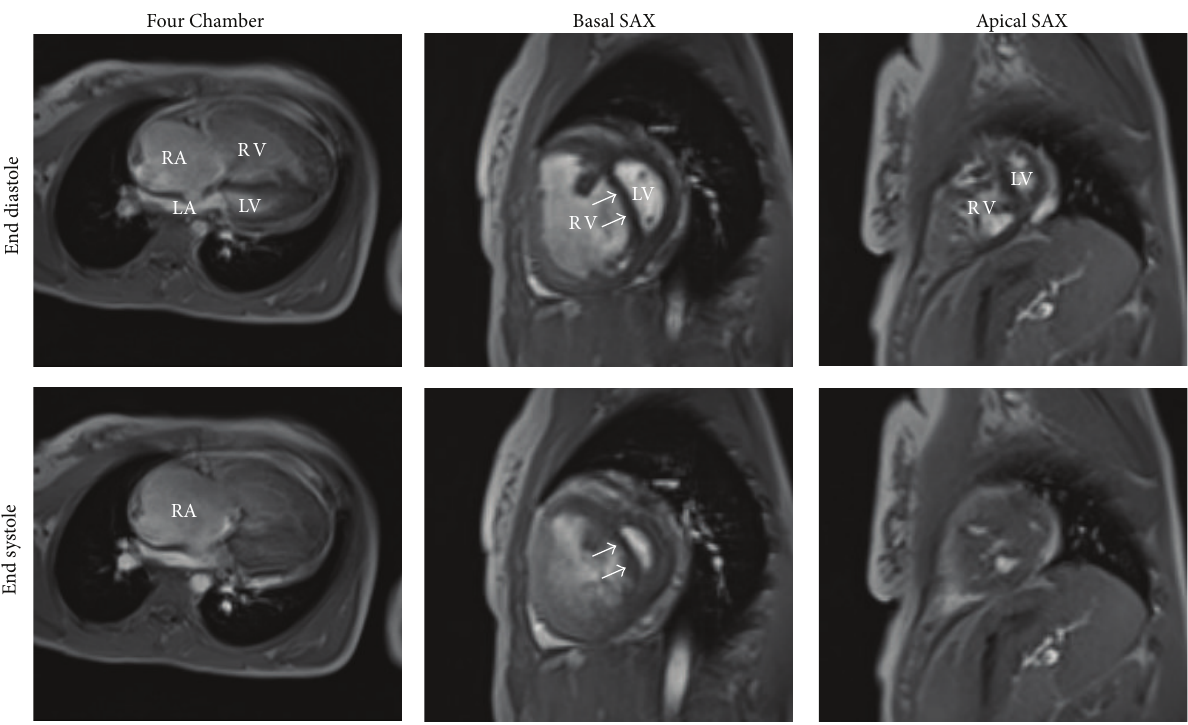
Figure 4: MRI images at end diastole and end systole. The images show markedly enlarged right ventricle (RV) and right article (RA) with leftward interventricular septal wall bowing (arrows). The RV is significantly trabeculated, especially at the apex. LV = left ventricle; LA = left atrium; SAX =